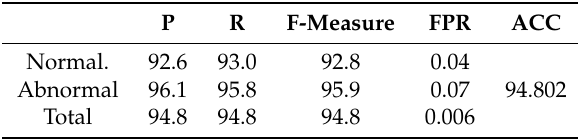
Table 10. Evaluation measures of normal and attacks classification for UNSW-Nb15 dataset. P R F-Measure FPR